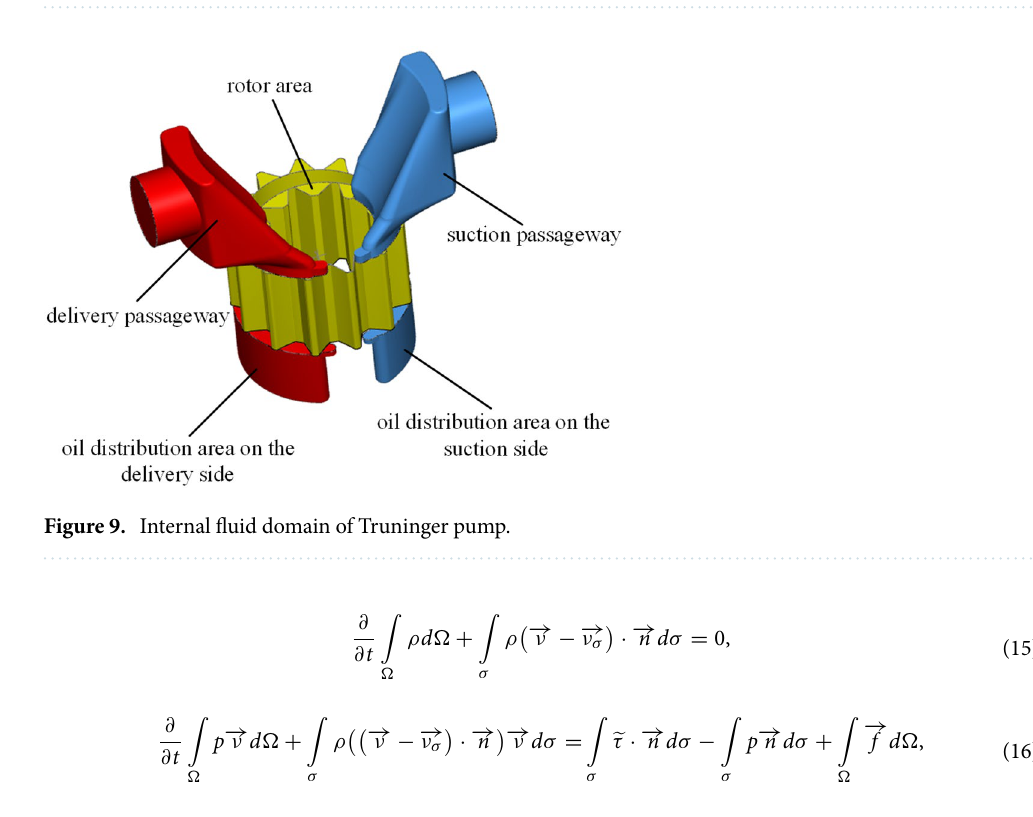
Figure 8. Influence of parameters on the average flow rate and flow ripple characteristics: ( a ) module, ( b ) addendum coefficient, ( c ) half angle of the tooth profile, and ( d ) pump speed.